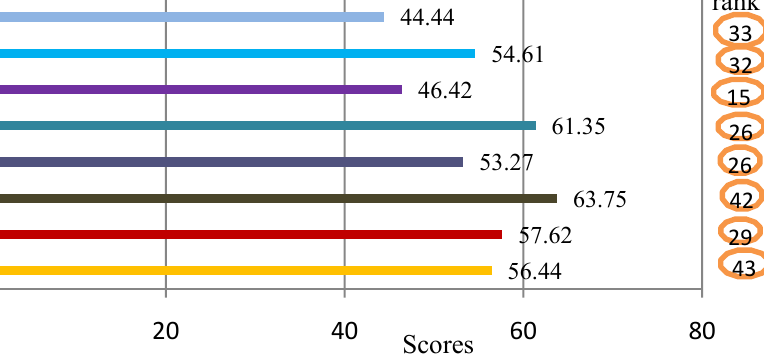
Fig. 1: Ukraine is ranking in “Enabling the business of agriculture” in